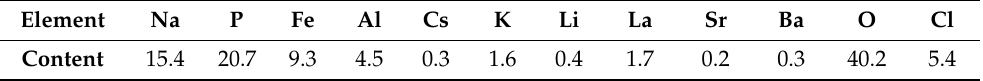
Table 1. Calculated elemental composition of NAFP glass samples (wt.%).